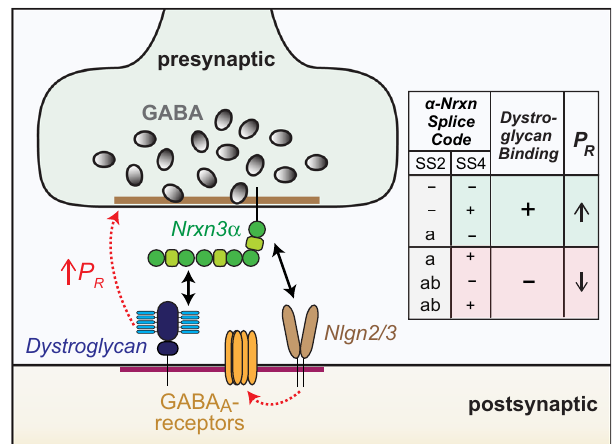
Fig.10|ModeloftranssynapticsynapticsignalingbyNrxn3 α anddystroglycan at inhibitory synapses. Summary cartoon of a complex between presynaptic Nrxn3 α and postsynaptic dystroglycan and Neuroligin-2 and -3 (Nlgn2/3). Right, summaryofthe α -neurexinsplicecodethatdictatesdystroglycanbinding,whichin turn retrogradely elevates the presynaptic release probability (P R